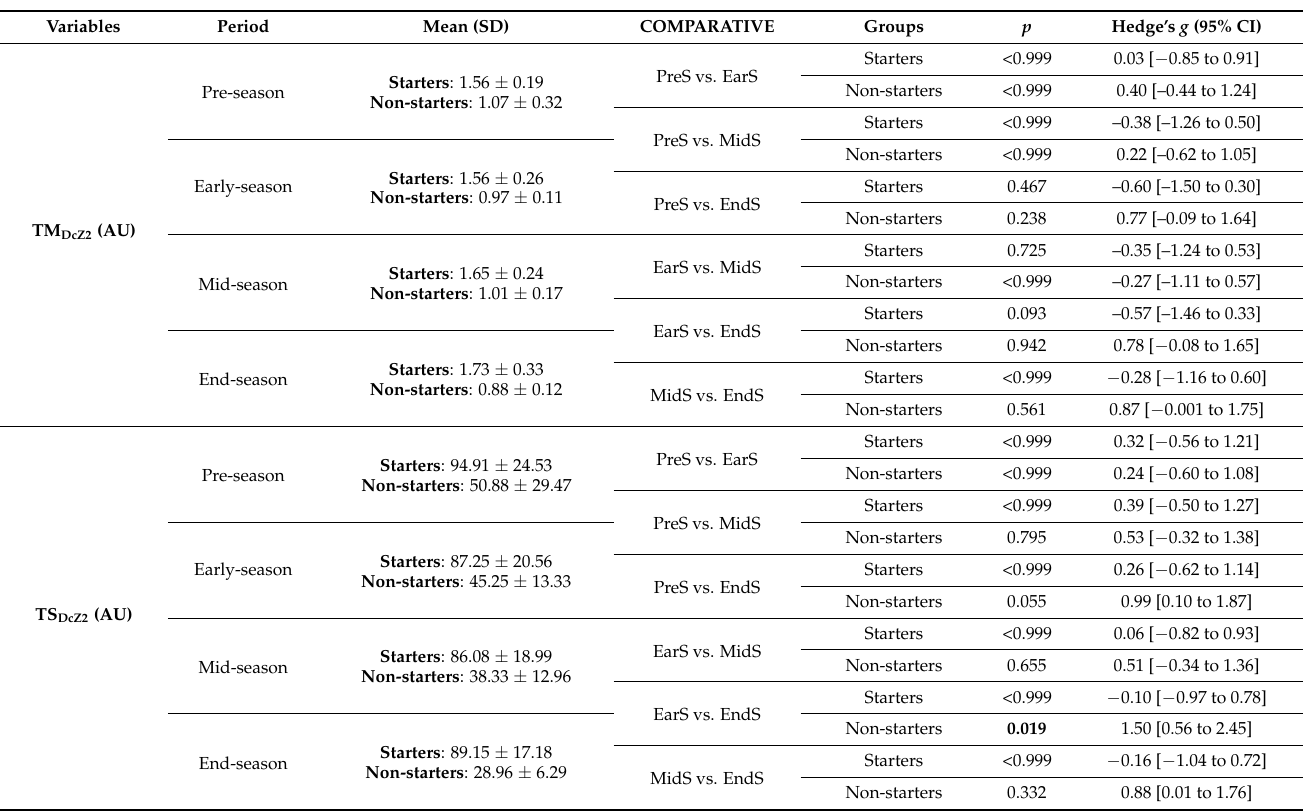
Table 5. Intragroup differences for binary comparisons between season periods in TM and TS in DcZ2 for both non- and starter